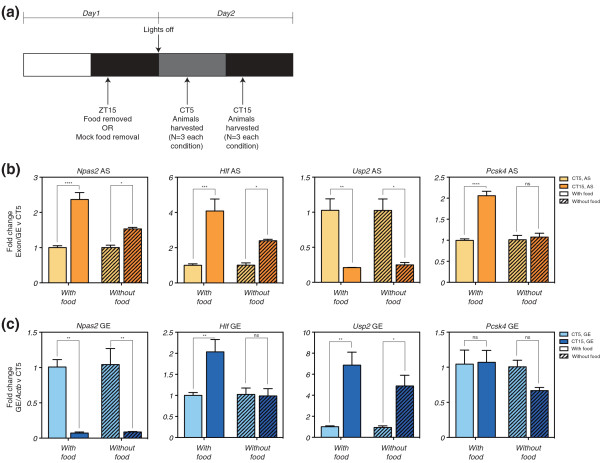
Fasting modulates the temporal regulation of circadian exons, and their relationship with transcript-level expression. (a) Schematic depicting the timing of important events during the two days of the fasting experiment; one day of LD followed by one day of DD. Colored boxes each depict 12 hour periods in the lighting schedule. White, day/lights on; black, night/dim red light; dark grey, subjective day/dim red light. ZT, Zeitgeber time (the time under an LD cycle); CT, circadian time (the corresponding time under a DD cycle). (b) Alternative splicing (AS) of four selected circadian exons. (c) Transcript-level expression for the same exons. For each combination of time point and feeding status, n = 3 and error bars represent standard error of the mean. The symbols above each pair of bars indicate the results of Bonferroni's post hoc test, comparing the two circadian time points in each feeding condition after a two-way ANOVA: Ns, not significant; *P ≤ 0.05; **P ≤ 0.01; ***P ≤ 0.001; ****P ≤ 0.0001.